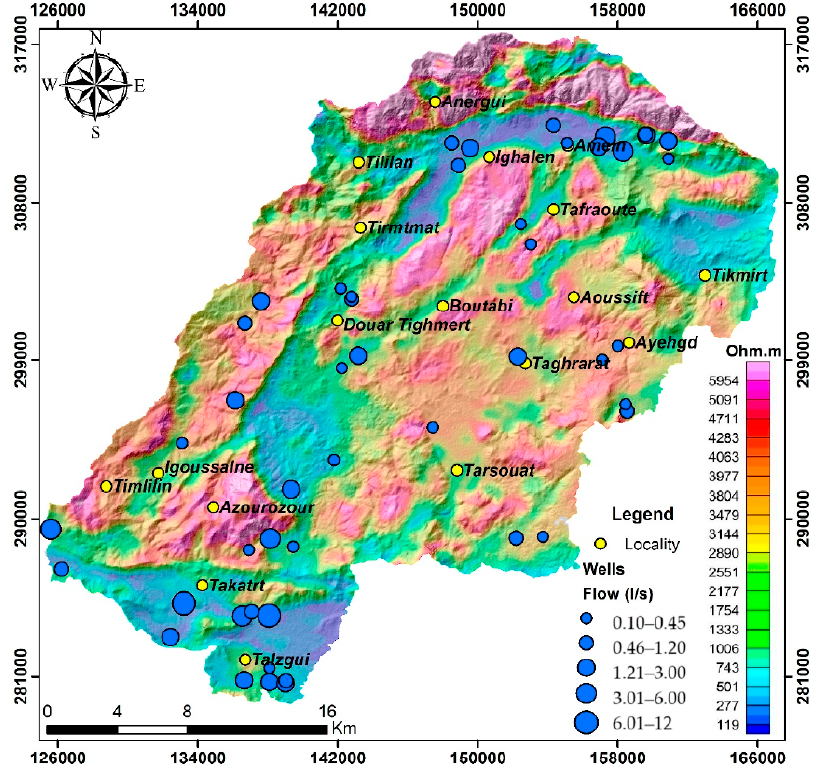
Figure 16. The 7200 Hz apparent resistivity map of the Ameln Basin shows the different areas of hydrogeological importance.